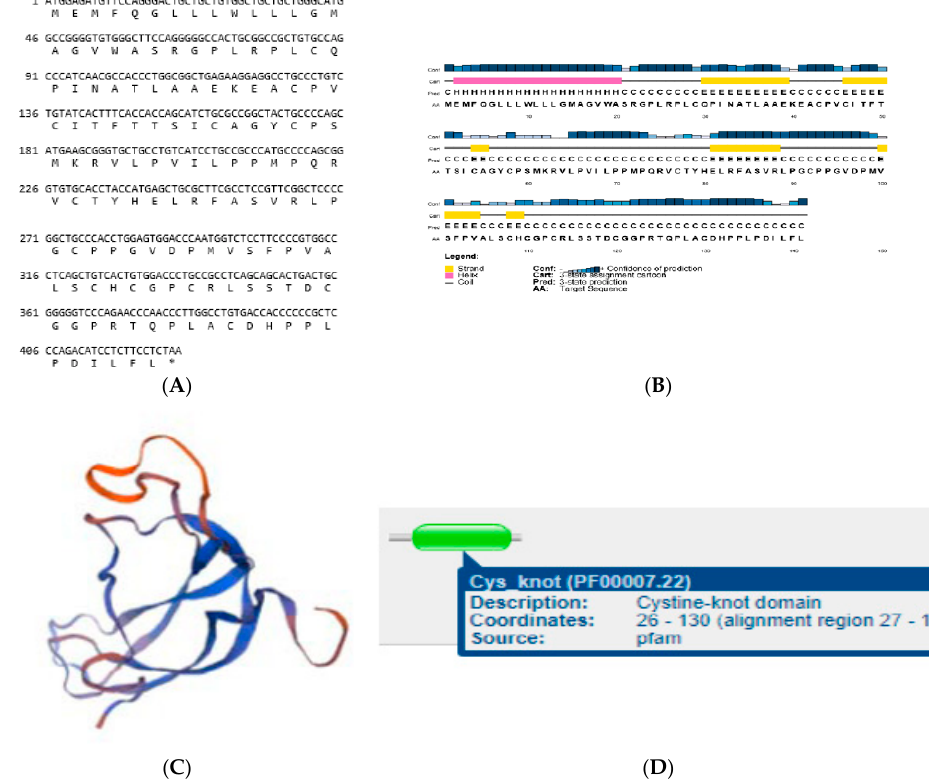
Figure 4. Assessment of the protein sequence encoded by LHB from the yak. The protein encoded by yak LHB contains a cysteine-knot domain. ( A ) The sequence of yak LHB and the predicted protein; ( B ) assessed secondary structures encoded by the LHB protein has a long vertical bar, short vertical bar, medium vertical bar, coil α -helix, extended strand, and sub-medium vertical bar turn; ( C ) estimated three-dimensional structures of LHB proteins; and ( D ) prediction of the conserved domain for LHB.